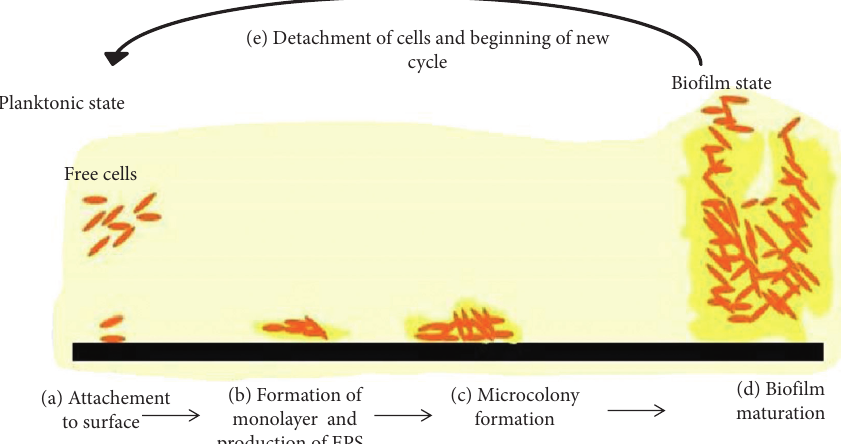
Figure 1: Typical illustration of biofilm formation. The process begins with reversible adhesion of the planktonic cells (brown ovals) with subsequent attachment to the surface (black) (a). The bacteria then form a monolayer and attach irreversibly, inducing an extracellular matrix formation (b). Later, a microcolony is formed where multilayers appear (c). In the following stages, the biofilm matures, forming characteristic structures due to polysaccharides existence (d). At the final step, some cells start to detach and the biofilm (yellow) disperses (e)